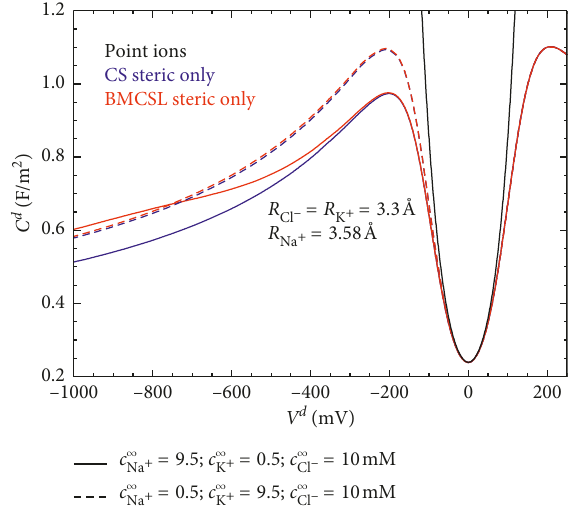
Figure 7: Dependence of the differential capacitance of the diffuse electric double layer on the potential drop across this layer, cal- culated using the CS and BMCSL steric interaction only models and mixed aqueous NaCl and KCl solutions with the indicated